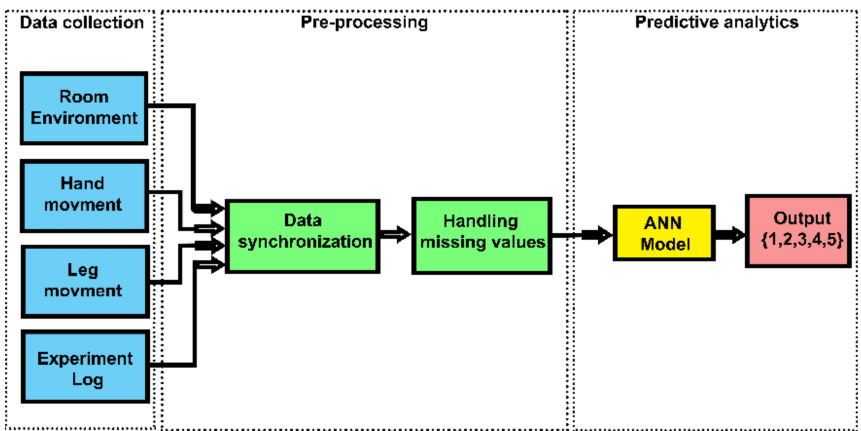
Figure 2. Block diagram of the proposed method using artificial neural networks.